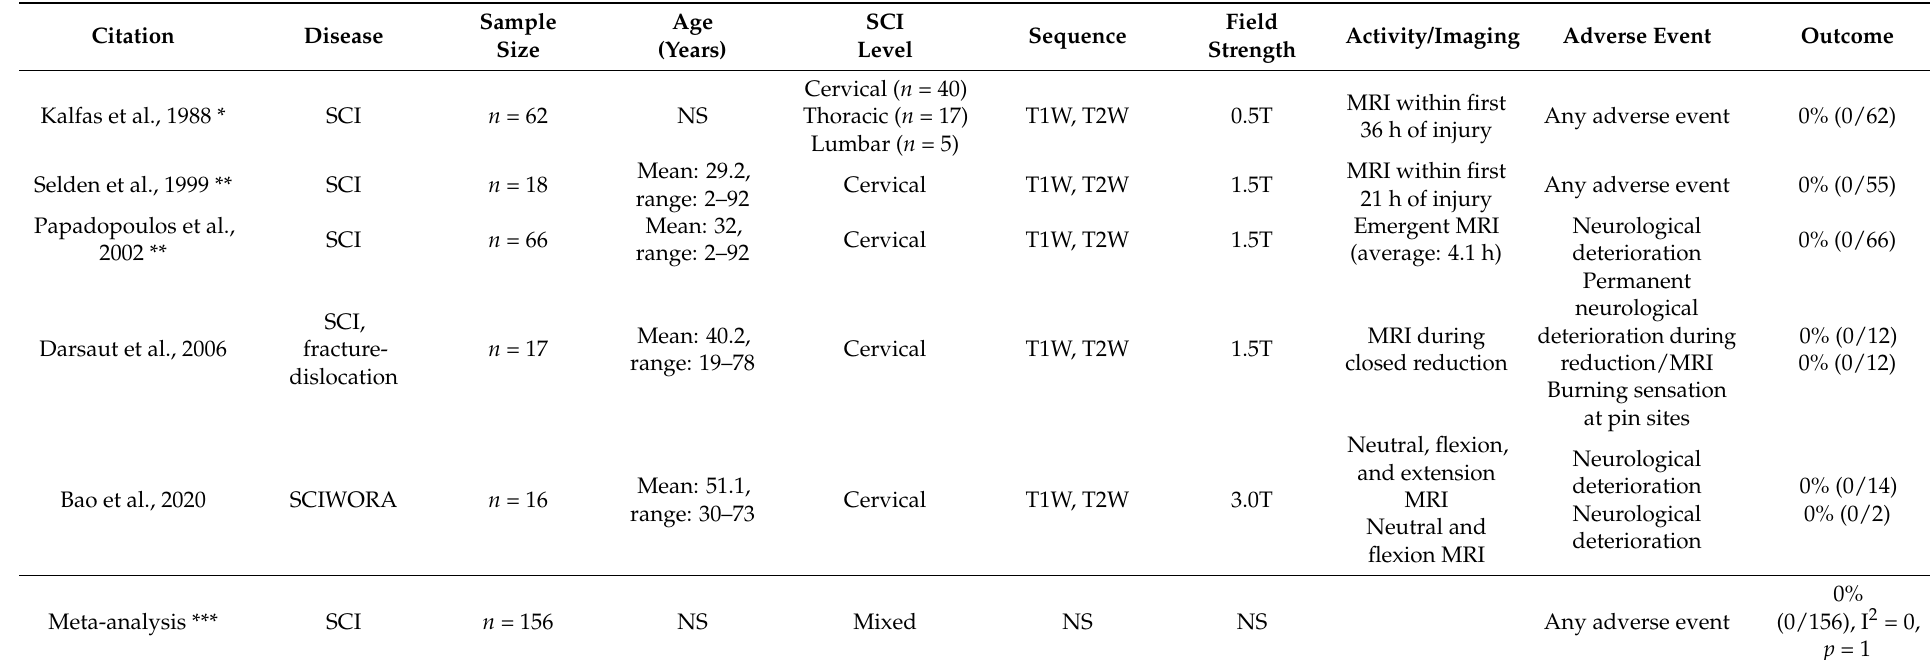
Table 7. Key Question 5: What is the frequency of adverse events when performing MRI in acute SCI